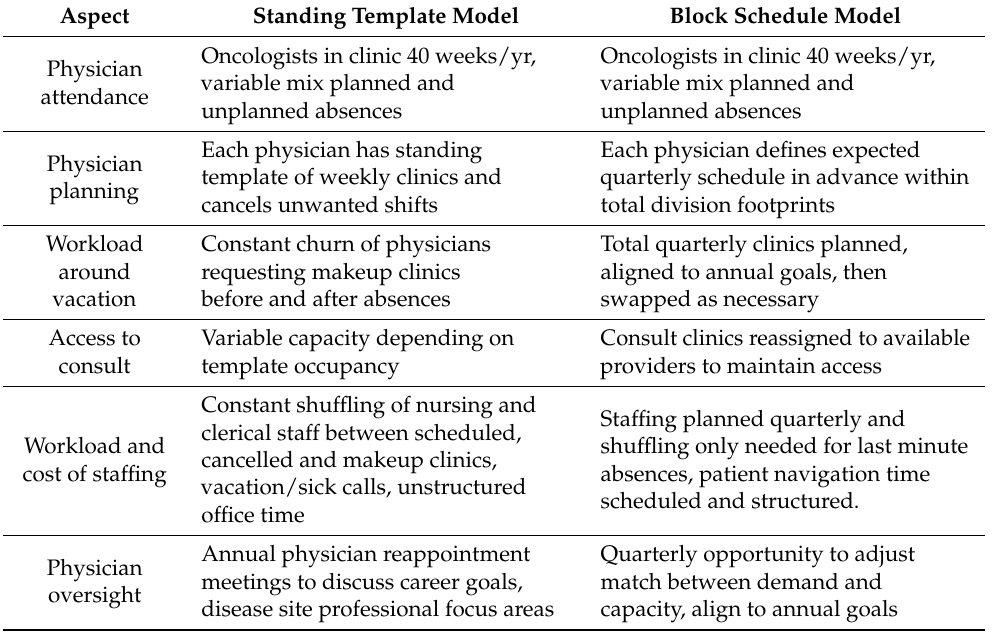
Table 1. Comparison of Standing Template of Block Schedule Operational Model for Ambulatory Oncology